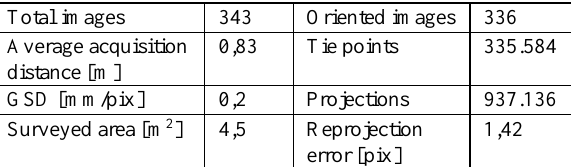
Table 5 . Characteristics of the photogrammetric dataset collected on the first day of the survey.